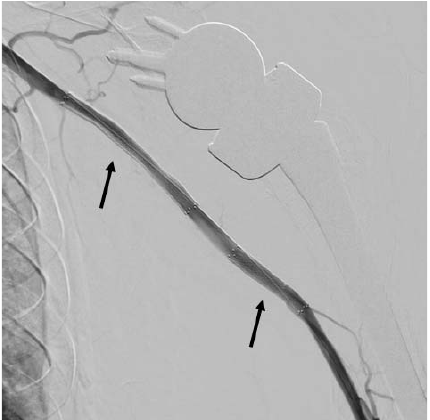
Figure 3: Repeat angiography of the left upper extremity after revascularization, showing a 6 × 60 mm stent in the axillary artery and a 6 × 30mm stent in the proximal brachial artery